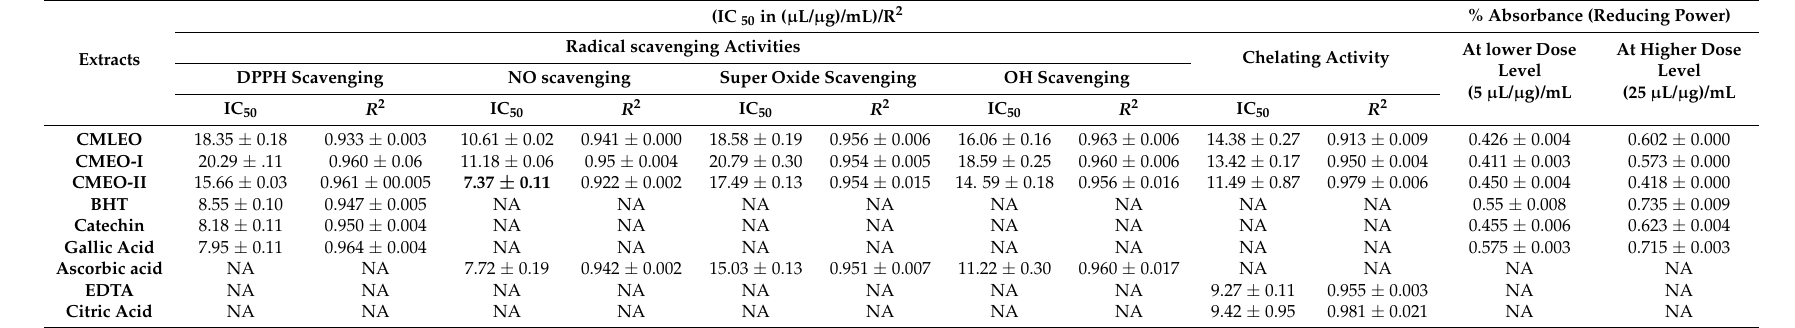
Table 2. Antioxidant properties in terms of IC 50 values in essential oils from different areal parts of C.